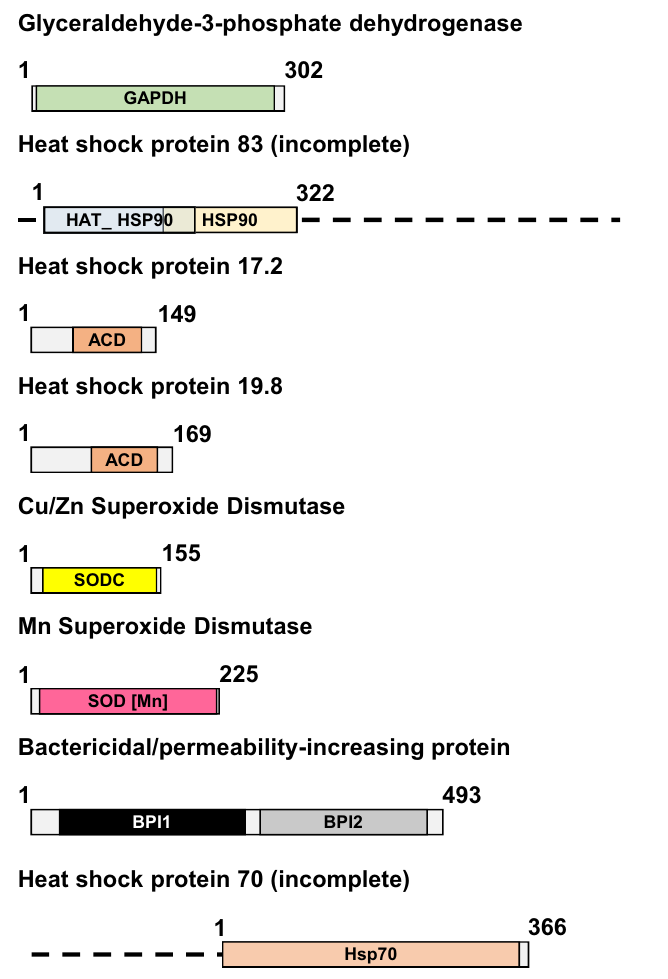
Figure 1. Scheme of the ORFs corresponding to the sequences identified. The numbers indicate the amino acid size of the ORF. For each ORF, the characteristic domains of each protein are indicated to indicate homology. The motifs are shown in the region of the protein where they are located. GAPDH: glyceraldehyde-3-phosphate dehydrogenase domain; HATPase_Hsp90: histidine kinase-like ATPase domain; Hsp90: heat shock protein 90 protein domain, ACD: alpha-crystallin domain; SODC: copper/zinc superoxide dismutase domain; SOD [Mn]: manganese superoxide dismutase domain; BPI1: BPI/LBP/CETP N-terminal domain; BPI2: BPI/LBP/CETP C-terminal domain. The figure was drawn with Powerpoint (Microsoft,